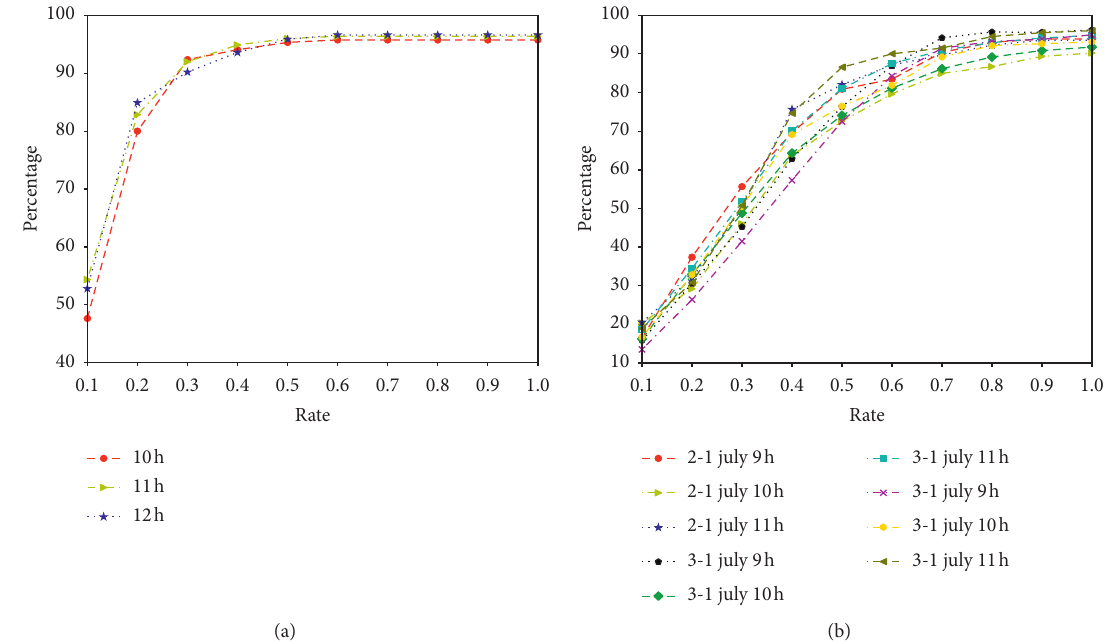
Figure 6: The change curves of p with different rates. (a) Shenluo highway. (b) Intersection of Songcheng